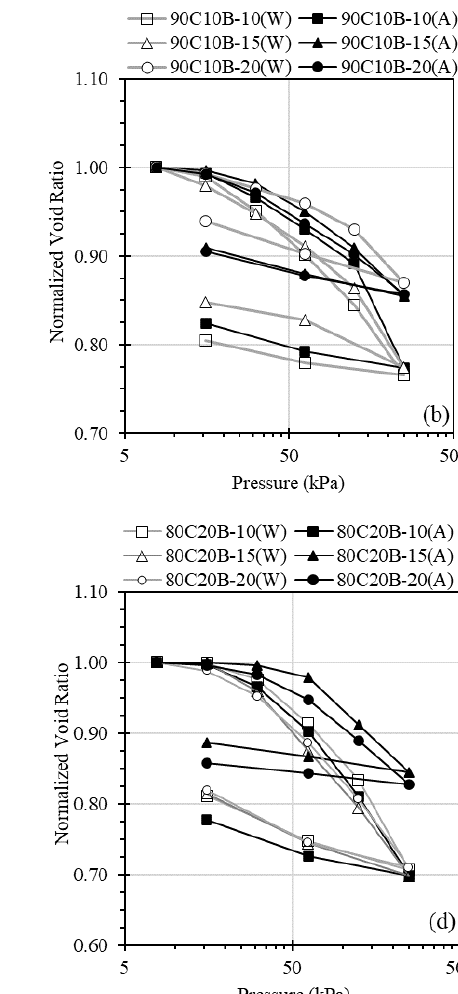
Fig. 6. Figure Normalized void ratio‒logaritmic pressure relationship of compacted claystone‒bentonite mixtures for Samples with (a) 5% bentonite, (b) 10% bentonite, (c) 15% bentonite, and (d) 20% bentonite. (Note: W=pure water, A=the acidic Figs. 7(a) and 7(b) show the coefficient of compression ( c c )